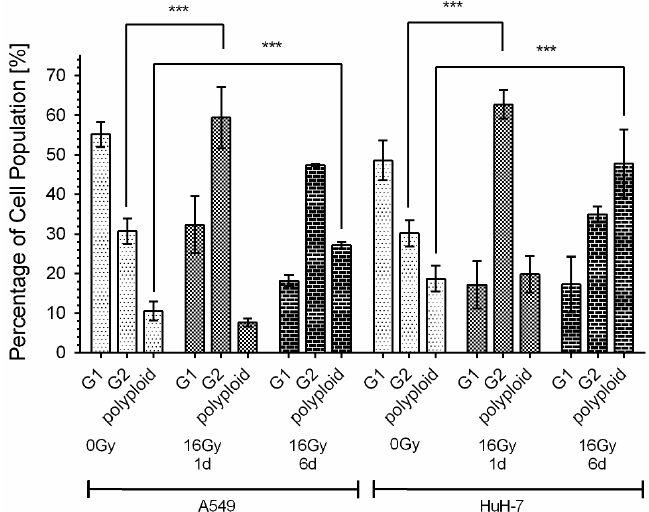
Figure 2. Cell cycle arrest and increase in the polyploid cell population after irradiation. HuH-7 and A549 cells showed a significant decrease in the percentage of cells in the G1 phase and an increase in the percentage of cells in the G2 phase within 24 h after 16 Gy gamma-irradiation. On day six after irradiation, a percentual increase in polyploid tumor cells was observed in both cell lines. Shown are mean values ± SD, two-way ANOVA, comparison between untreated control cells and irradiated cells of the respective cell line on day one (1 d) and day six (6 d) after irradiation, correction for multiple comparisons by Bonferroni, N ≥ 4, *** p < 0.001. 2.2. Remnant Tumor Cells after 16 Gy Gamma-Irradiation Show the Classic Hallmarks of Senescence In addition to the effects on the cell cycle, typical changes in cell morphology oc- curred after irradiation (Figure 3). The cells exhibited increased size, they seemed to be swelling, and their morphology was reminiscent of fried eggs, with a protruding nucleus surrounded by a flattened cytoplasm.